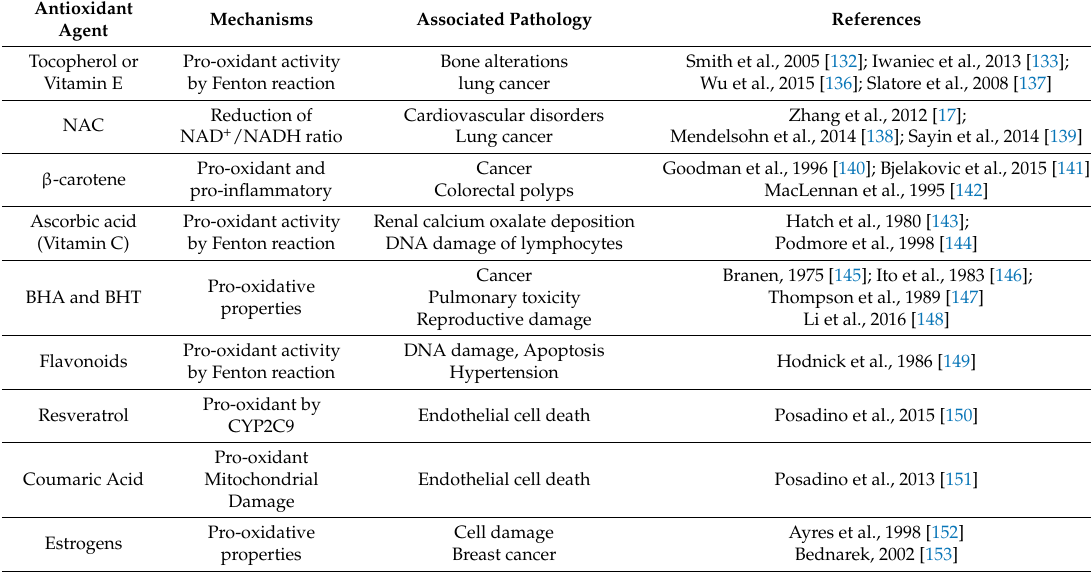
Table 2. Side effects of antioxidant agents in inflammation-associated